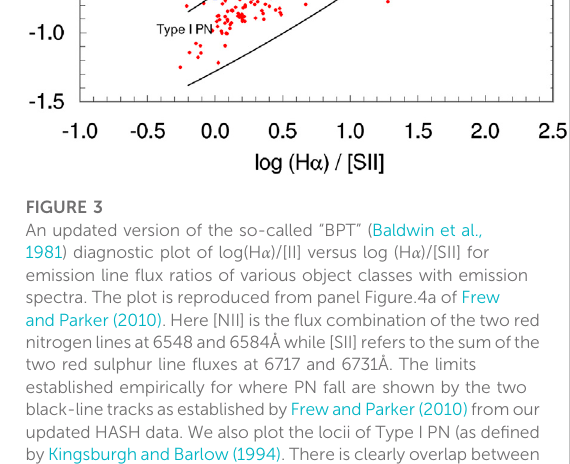
In Figure 5 are shown four examples of spectra of typical PN mimics - three of which are for the same objects as the images in Figure 4. The top left spectrum is an example of ionised circumstellar matter and the top right for a more classic HII region. The spectra are very similar with H β only in the blue - an important diagnostic. In fact the circumstellar matter example is also a HII region (Strömgren sphere) but the ionisation is by a single, isolated star and not a more general HII region which may be large, complex and host many young stars. We make this classi fi cation distinction in HASH. The strength of [NII] relative to H α and the [SII] lines indicate low density for the HII region. This should be compared to the PN VLE spectrum in Figure 2.